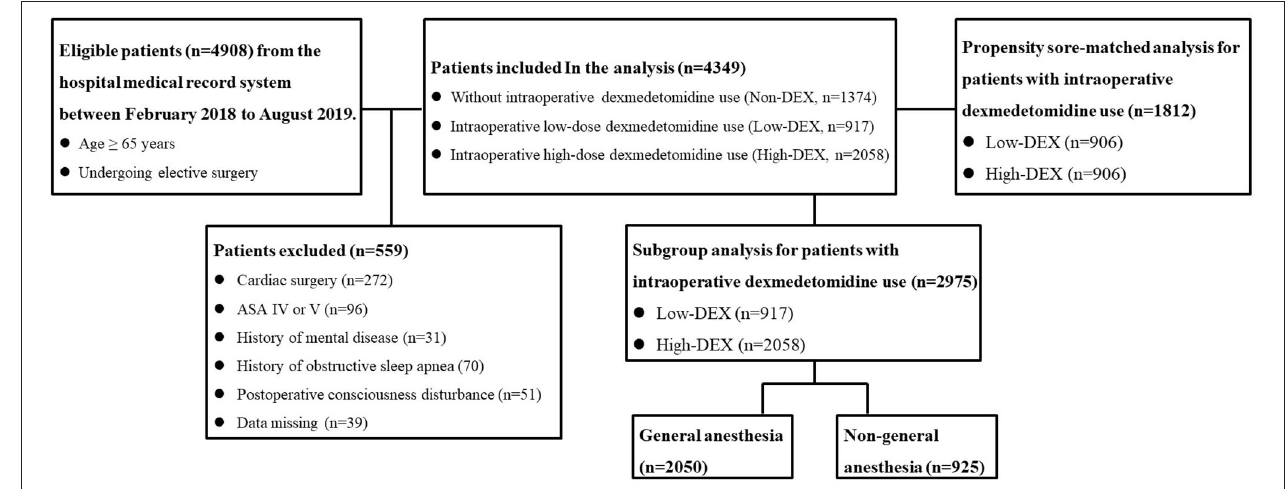
FIGURE 1 | The study population with the inclusion and exclusion